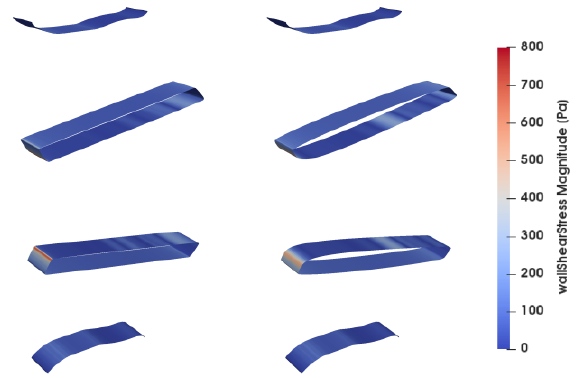
Fig. 4. Distribution of wall shear stress magnitude at maximum flow rate on the original geometry (left) and the final modification (right) .